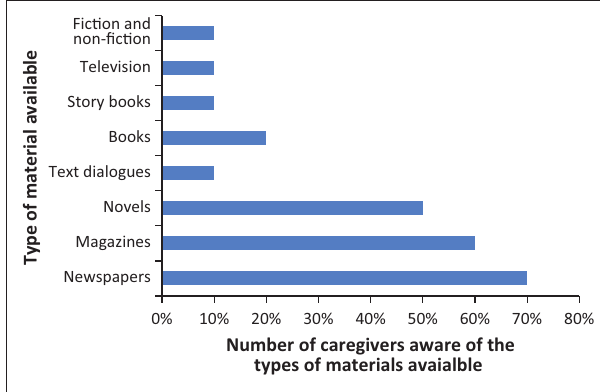
FIGURE 2: Reading strategies implemented by the caregivers.